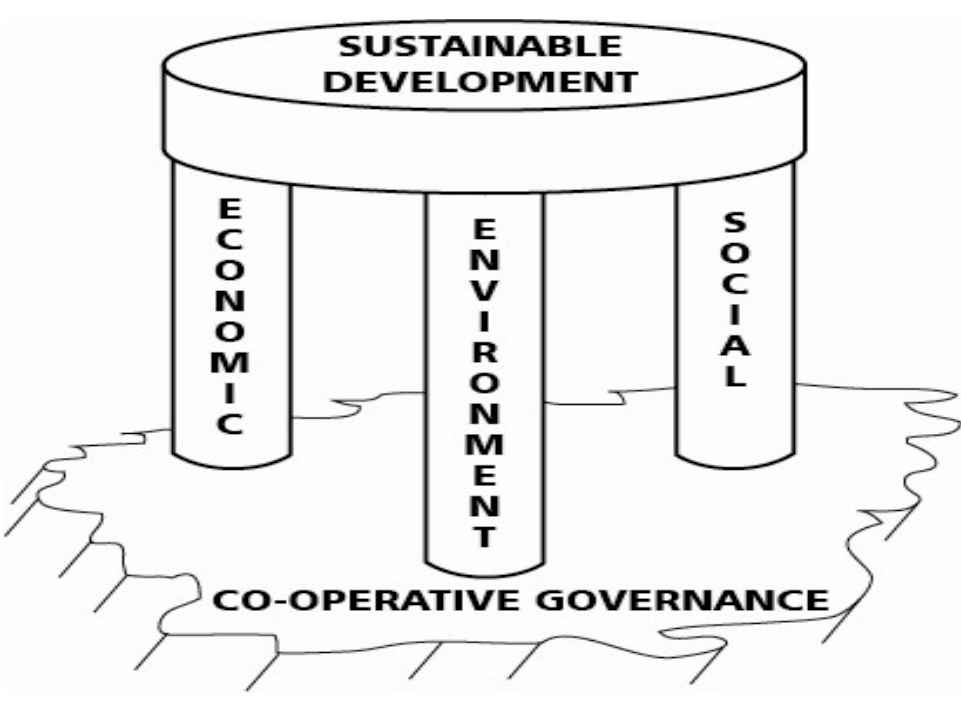
Figure 1: Depiction of links between SD and COG. (Source: Author’s [Nealer] own work) The various environmental, social and economical dimensions do not function in separate silos but are dependent on each other via another dimension, namely: the grounding and legislated governance framework. These four dimensions which are dynamic and constant within a SD context, include the